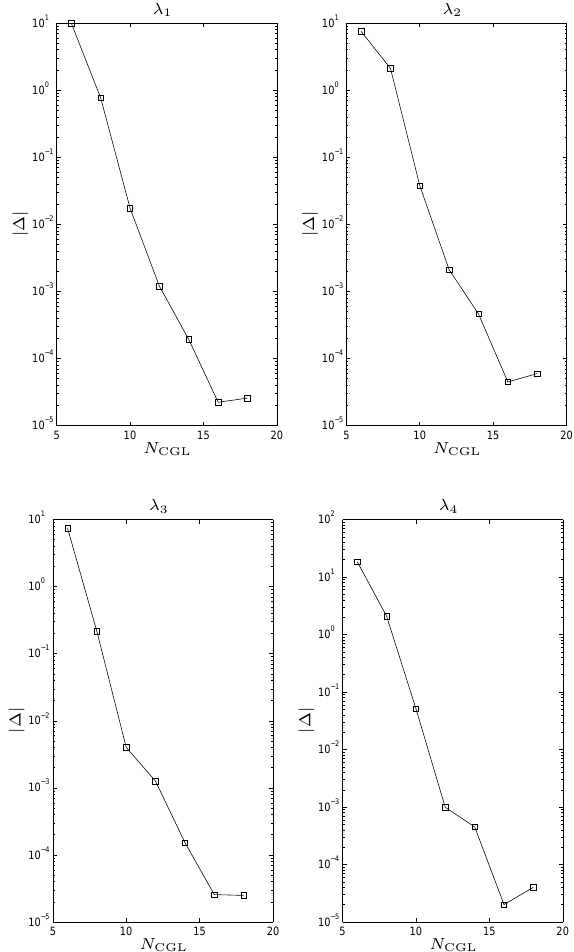
Figure 5: Convergence analysis. First four dimensionless frequen- cies λ i = ω i ( a 2 / h ) √︀ ρ / E 2 of a moderately thick ( a / h = 10 ) square fully clamped [45/ − 45] 3 deep cylindrical panel with a / R β = 2 . Values computed using LD1